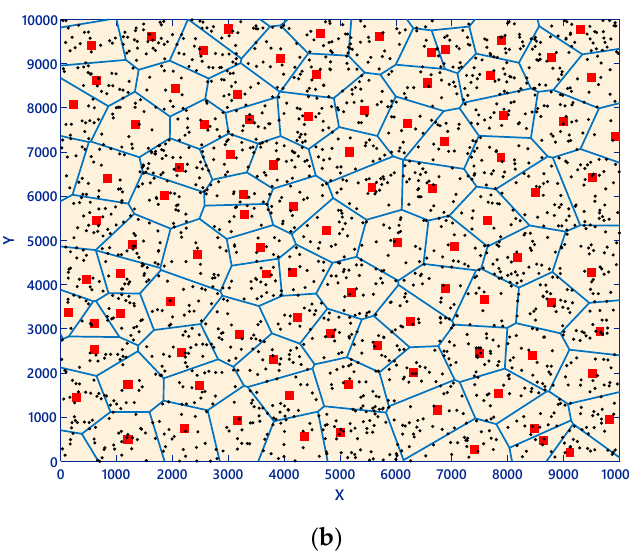
Figure 4. Comparison between PSO and SA in 5G planning at 28 GHz with urban micro-cells (UMi) standalone deployment architecture. ( a ) and ( b ) represent the results obtained for PSO and SA, respectively. Users are represented by black dots, whereas red squares represent UMi. Table 4. Performance comparison (PSO vs. SA) in different user distribution for 5G network planning at 28 GHz.